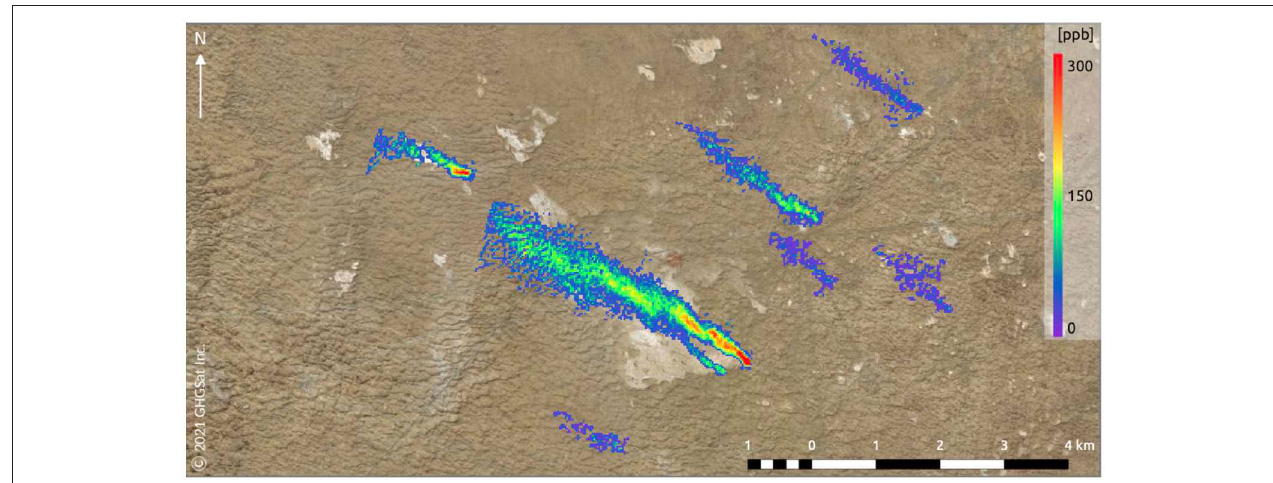
FIGURE 8 | Eight separate methane plumes captured by GHGSat in a single image, representing a total emission rate of about 10,000 kg/hour. Four of the larger plumes on the left are emissions from pipelines (likely problems with valves), with the remaining emissions from unlit flares.